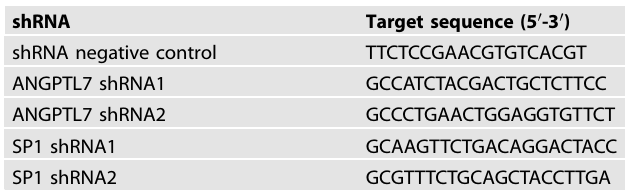
Table 1. The sequence of shRNA.